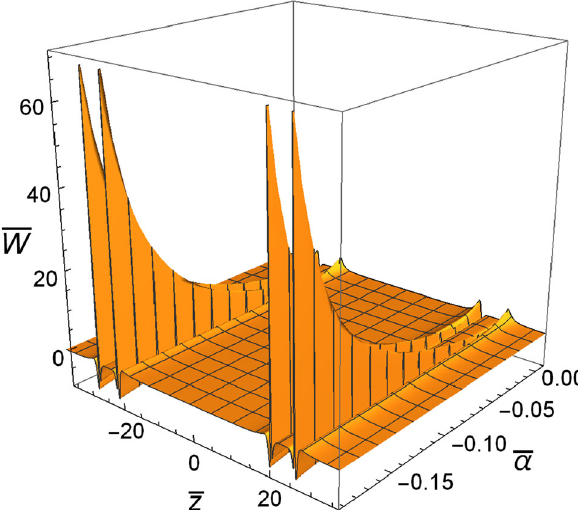
Fig. 20 The effect of the parameter ¯ α on the effective potential with ¯ b = 13 and ¯ d = 2 . 3 for case 3